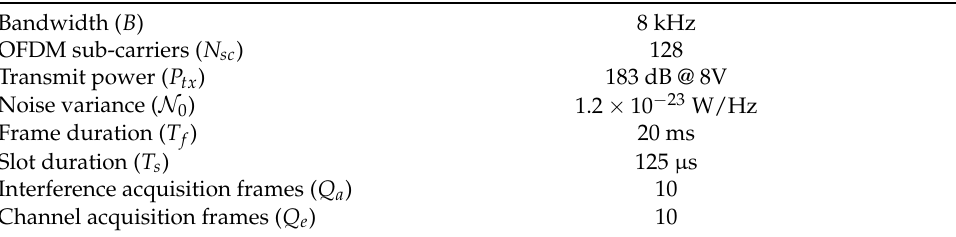
Table 2. Simulation parameters.